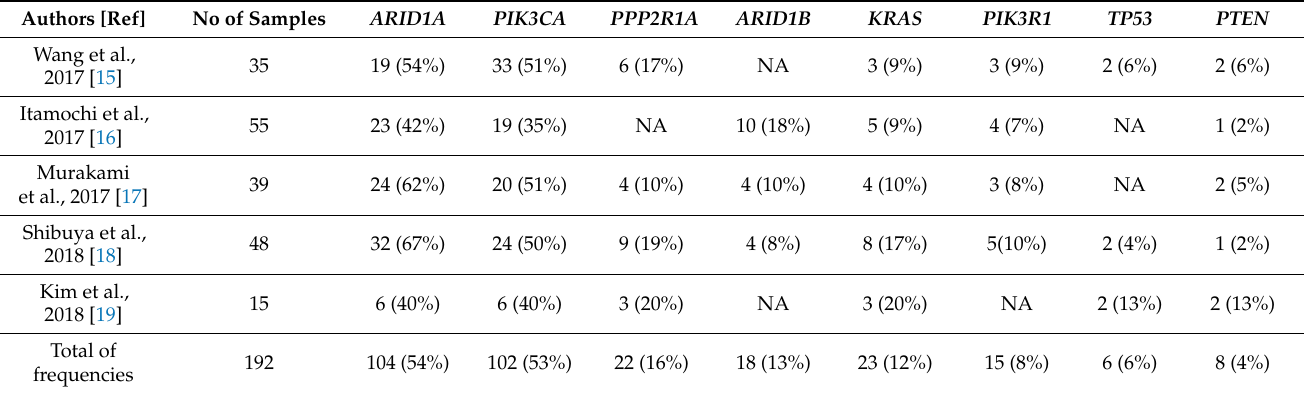
Table 1. Frequency of somatic gene alterations in ovarian clear cell